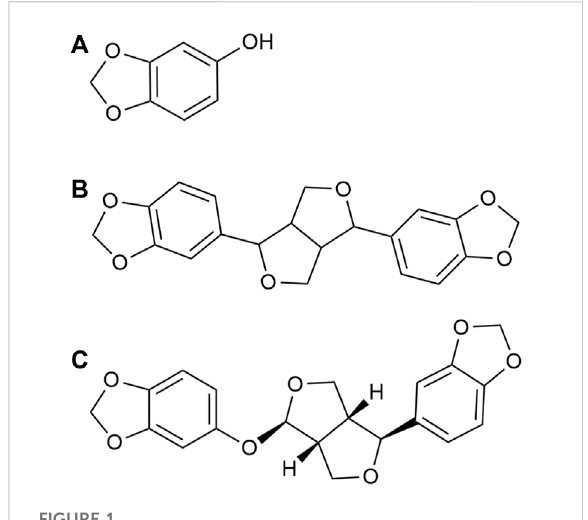
FIGURE 1 Chemical structures of (A) sesamol (B) sesamin, and (C)